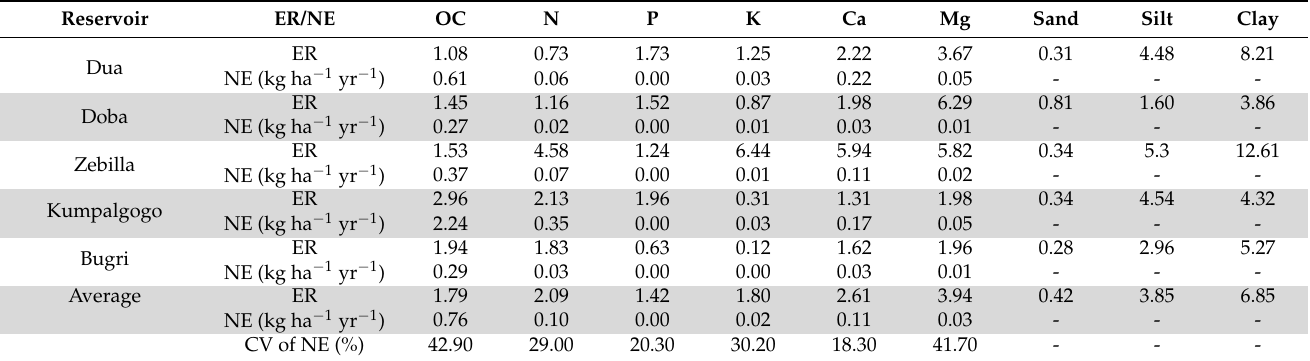
Table 10. Enrichment ratios (ER) and rate of nutrient export (NE) and particles in reservoir sediments